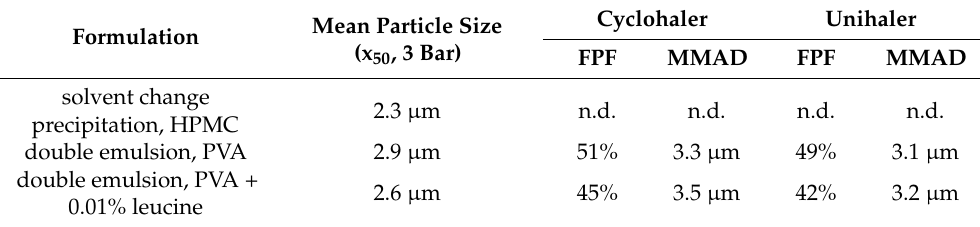
Table 2. Mean particle size from laser diffraction measurements (3 bar), mass median aerodynamic diameter (MMAD) and fine particle fraction (FPF) < 5 µ m from aerodynamic characterisation in the NGI utilising two capsule-based devices for different dry powder formulations (average of n = 3). n.d. = not